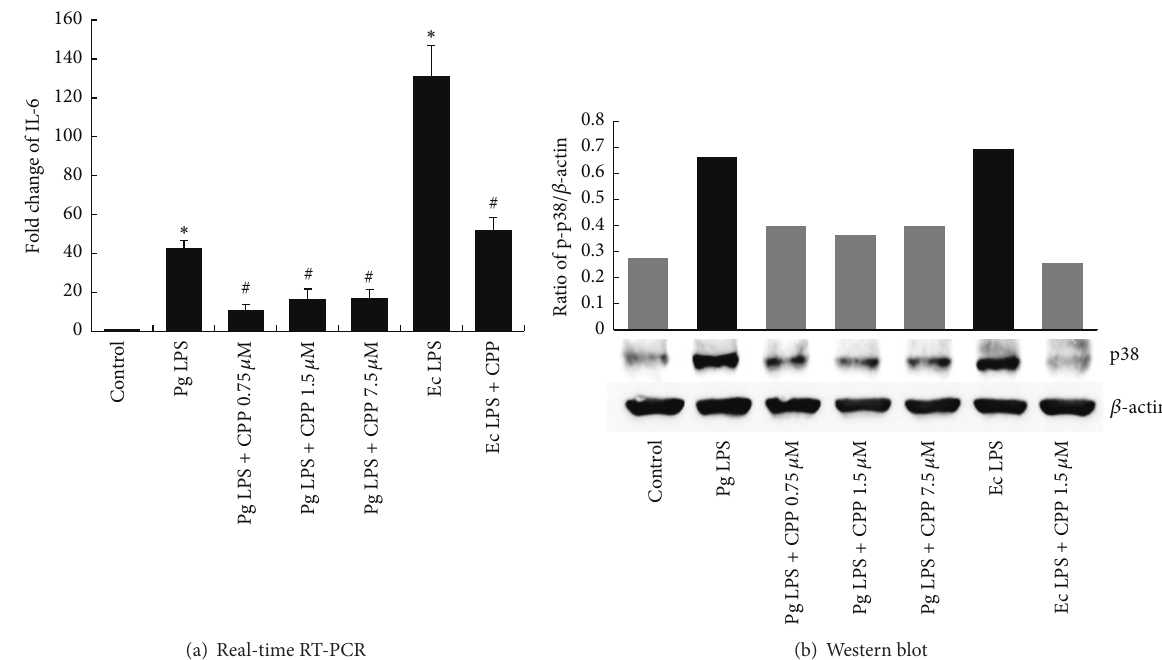
Figure 4: Effects of GV1001 on LPS-induced IL-6 and p-p38 expression in hDPCs. 0.75, 1.5, and 7.5 𝜇 M GV1001 was added to hDPCs treated with 1 𝜇 gmL −1 of E. coli LPS or 20 𝜇 gmL −1 of P. gingivalis LPS for 10 hrs. Real-time RT-PCR and Western blot revealed downregulation of (a) IL-6 and (b) phosphorylated p38, respectively, after exposure to 1 𝜇 g mL −1 of E. coli LPS or 20 𝜇 g mL −1 of P. gingivalis LPS incubated with GV1001 (0.75, 1.5 𝜇 M, and 7.5 𝜇 M). Each value indicates the mean ± SEM of three independent experiments. # indicates a significant difference ( 𝑃 < 0.05 ) relative to cells treated with LPS in the presence of